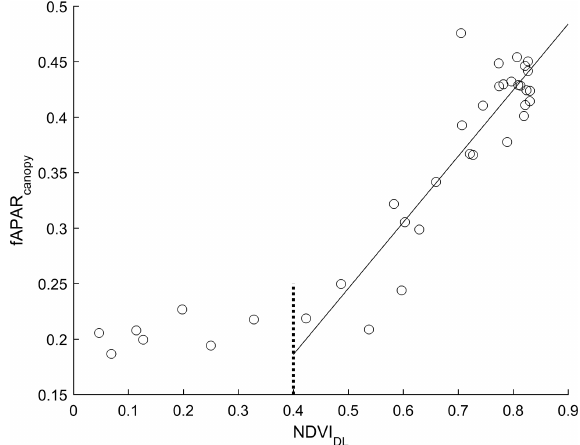
Figure 4. Correlation between ground-measured fraction of ab- sorbed PAR by the canopy (fAPAR canopy ) and MODIS-derived NDVI smoothed with a double logistic function in TIMESAT (NDVI DL ) in 8-day intervals. Only NDVI DL values ≥ 0.4 were in- cluded in the OLS regression resulting in the black line. R 2 = 0.81 and N =